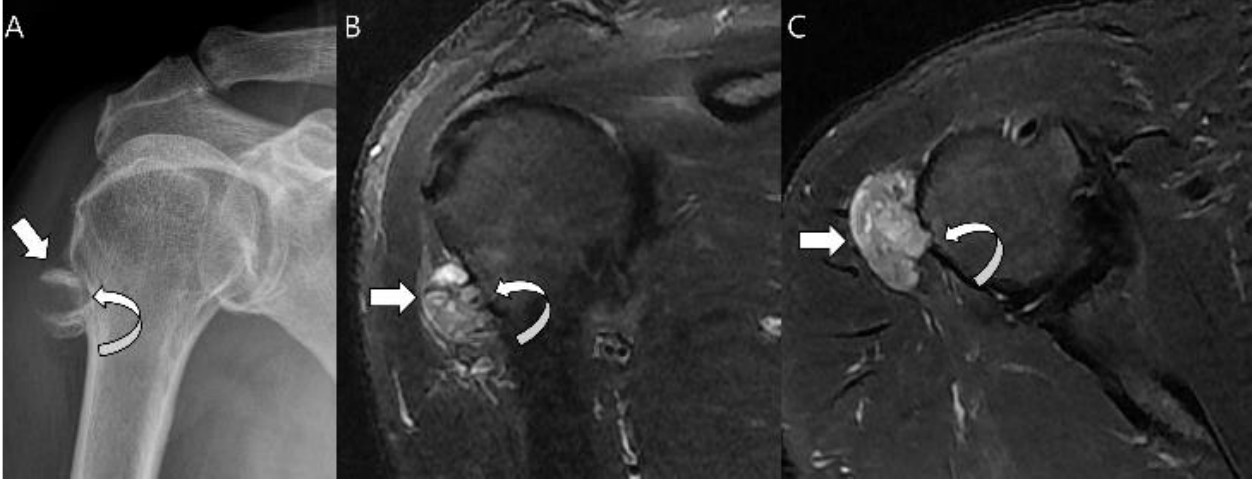
Figure 11. Periosteal chondrosarcoma grade 1 of the humerus in a 66-year-old man. ( A ) Radio- graph shows a juxtacortical mass with Codman’s triangles (arrow) in the humerus. Note the associ- ated cortical thinning (curved arrow). ( B ) Coronal and ( C ) axial T2-weighted images with fat sup- pression show a juxtacortical mass with high signal intensity and lobular margins (arrows). The mass has caused cortical erosion (curved arrow) but no evident marrow invasion.